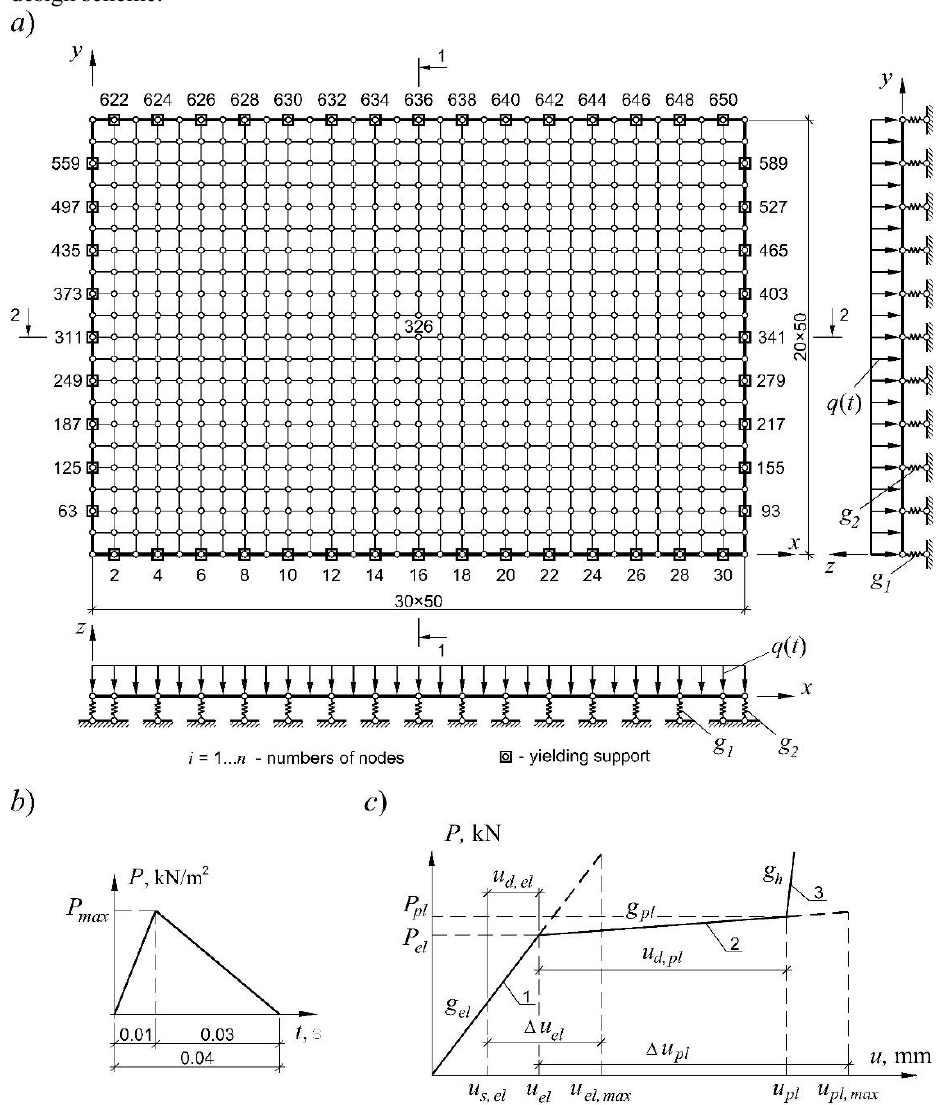
Fig. 2. Scheme of the slab division into finite elements ( a ), law of variation of the load adopted in numerical calculations ( b ) and deformation curve of yielding supports ( c ): 1 –elastic phase of support deformation; 2 – elasto-plastic phase of supports deformation; 3 –hardening